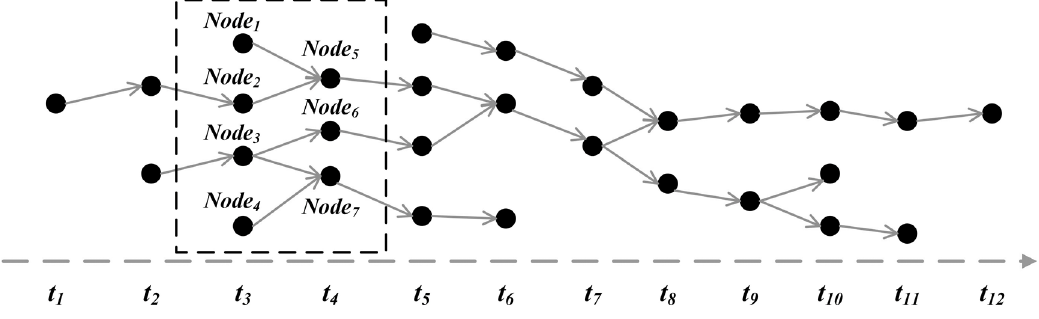
Figure 2. A schematic diagram of a graph-based process object.